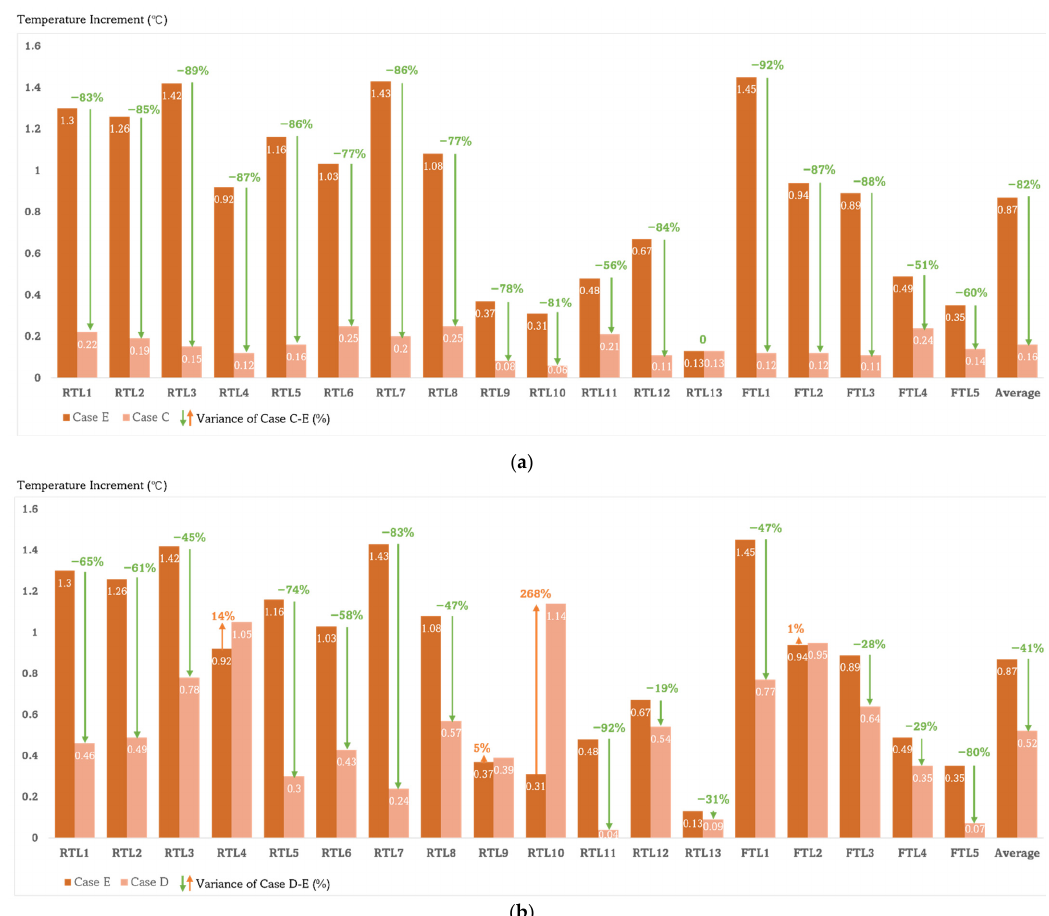
Figure 11. ( a ). Temperature increment of Case C & E and the variance of Case (C–E) % of each test line and the average value, Variance of Case (C–E) was calculated with the equation (cid:1829)(cid:1853)(cid:1871)(cid:1857) ((cid:1829) − (cid:1831)) = (cid:2176) (cid:2159)(cid:2183)(cid:2201)(cid:2187)(cid:2159) (cid:2879)(cid:2176) (cid:2159)(cid:2183)(cid:2201)(cid:2187)(cid:2161) % ( T CaseC is the temperature increment of each test line in Case C and T Case E is the temperature increment of each test line in Case E). ( b ) . Temperature increment of Case D & E and the variance of Case (D–E) % of each test line and the average value, Variance of Case (D–E) was calculated with the equation Case ( D − E ) = T CaseD − T CaseE % ( T CaseD is the temperature increment of each test line in Case D and T CaseE is the temperature increment of each test line in Case